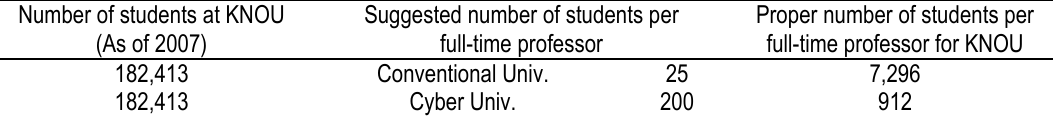
Table 5. Proper number of students per full-time professor for KNOU Number of students at KNOU Suggested number of students per (As of 2007)